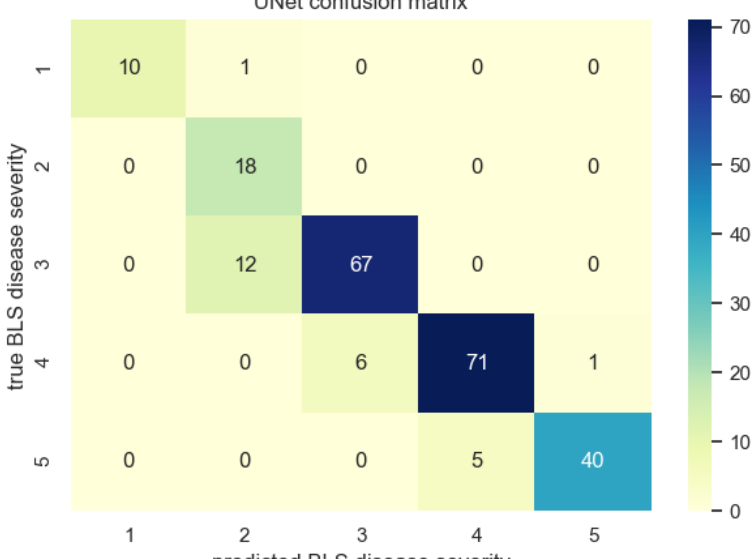
Figure 12. BLSNet confusion matrix.